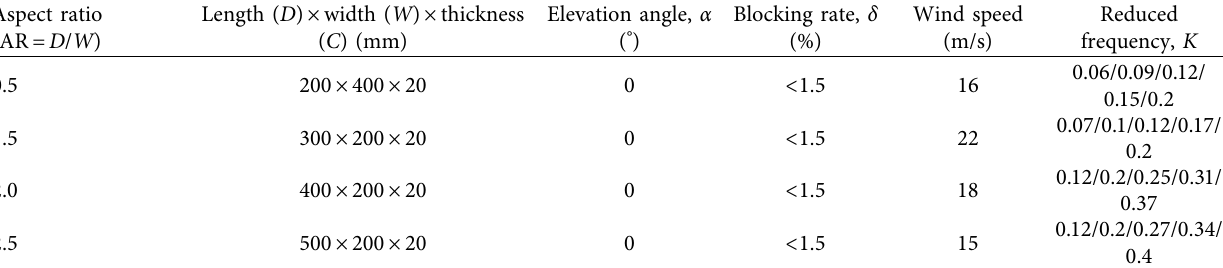
Figure 1: Definition of each part of radar antenna model and balance coordinate system. (a) AR < 1. (b) AR ≥ 1. (c) AR < 1. (d) AR ≥ 1. AR, aspect ratio. Table 1: Dimensions of the antenna model and test